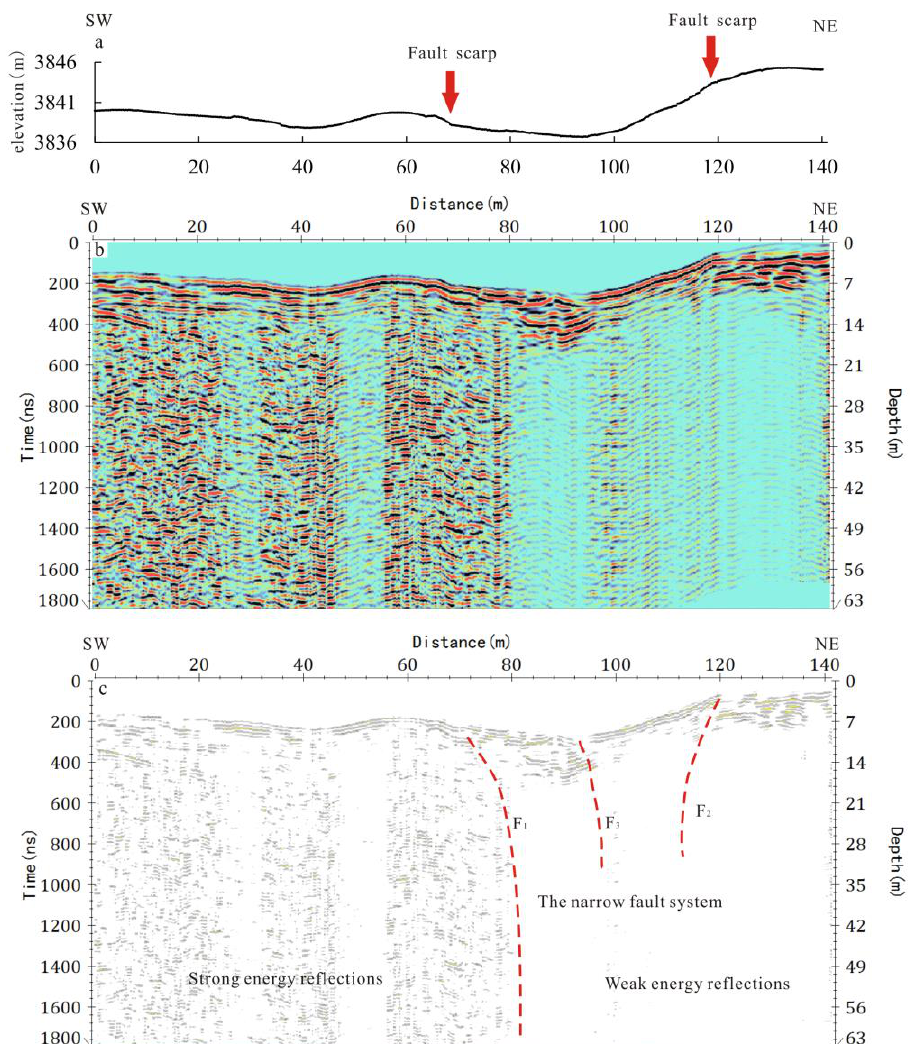
Figure 7. The processed and interpreted 25 MHz GPR profile. ( a ) Topographic data of the 25 MHz GPR measuring line (line 1 in Figure 2b). ( b ) The processed 25 MHz GPR image. ( c ) Conceptual profile of 25 MHz GPR data. Red dotted lines imply the interpreted faults F 1 , F 2 and F 3 .